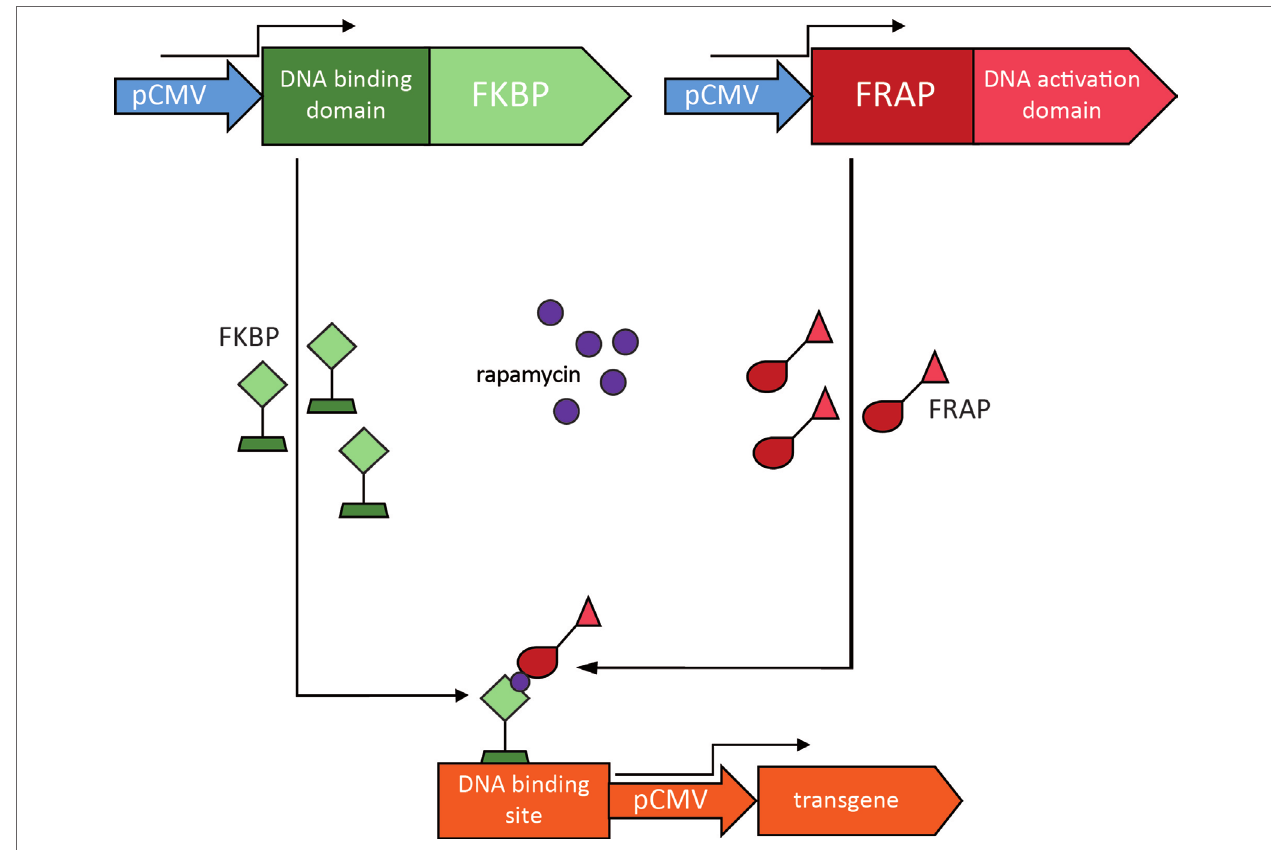
FIGURE 4 | Rapamycin regulation system. In this example, the constitutively active human cytomegalovirus promoter (pCMV) drives the expression of two transcription factors, one consisting of the FK-binding protein (FKBP) fused to a DNA binding domain (in green), the other consisting of an FKBP12 rapamycin- associated protein (FRAP) fused to a DNA activation domain (in red). Rapamycin enables dimerization of the transcription factors and the resulting heterodimer is able to drive expression of the transgene of